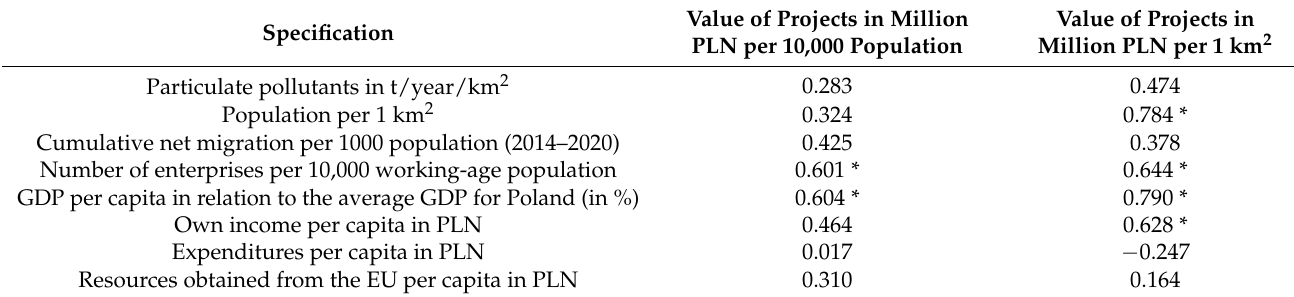
Table 4. Pearson’s linear correlation coefficients between the value of implemented projects co- financed by EU funds per 10,000 population and per km 2 in million PLN and environmental and socio-economic indicators of metropolises in Poland in the 2014–2020 Financial